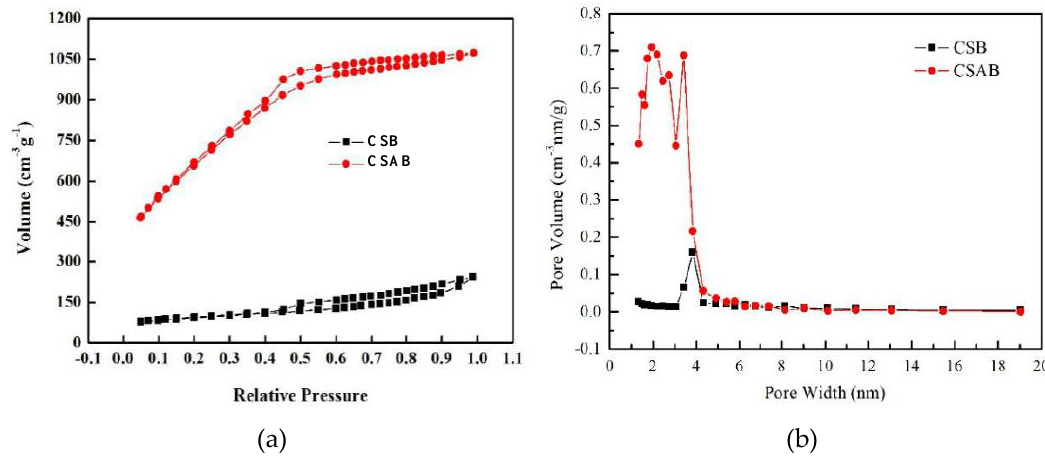
Figure 1. ( a ) Nitrogen adsorption-desorption isotherms; ( b ) pore size distribution.